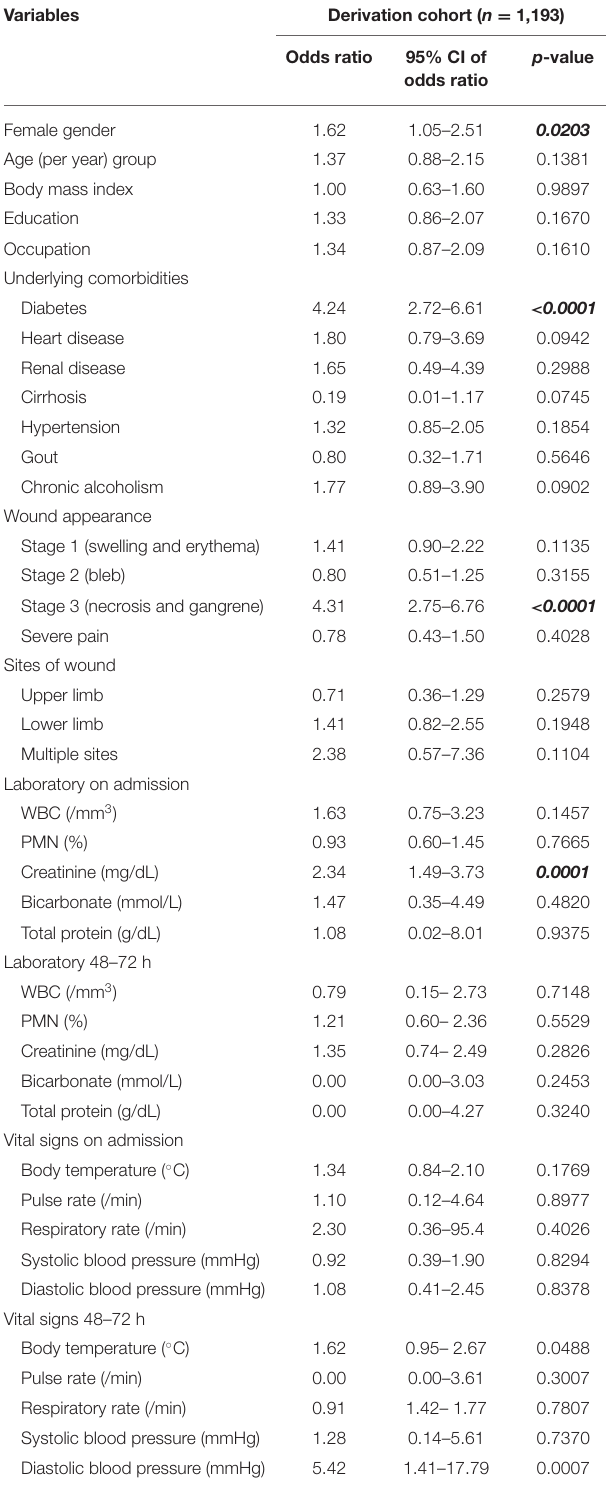
TABLE 2 | Univariable analysis for risk factors significantly associated with amputation in patients with necrotizing fasciitis in the derivation cohort.